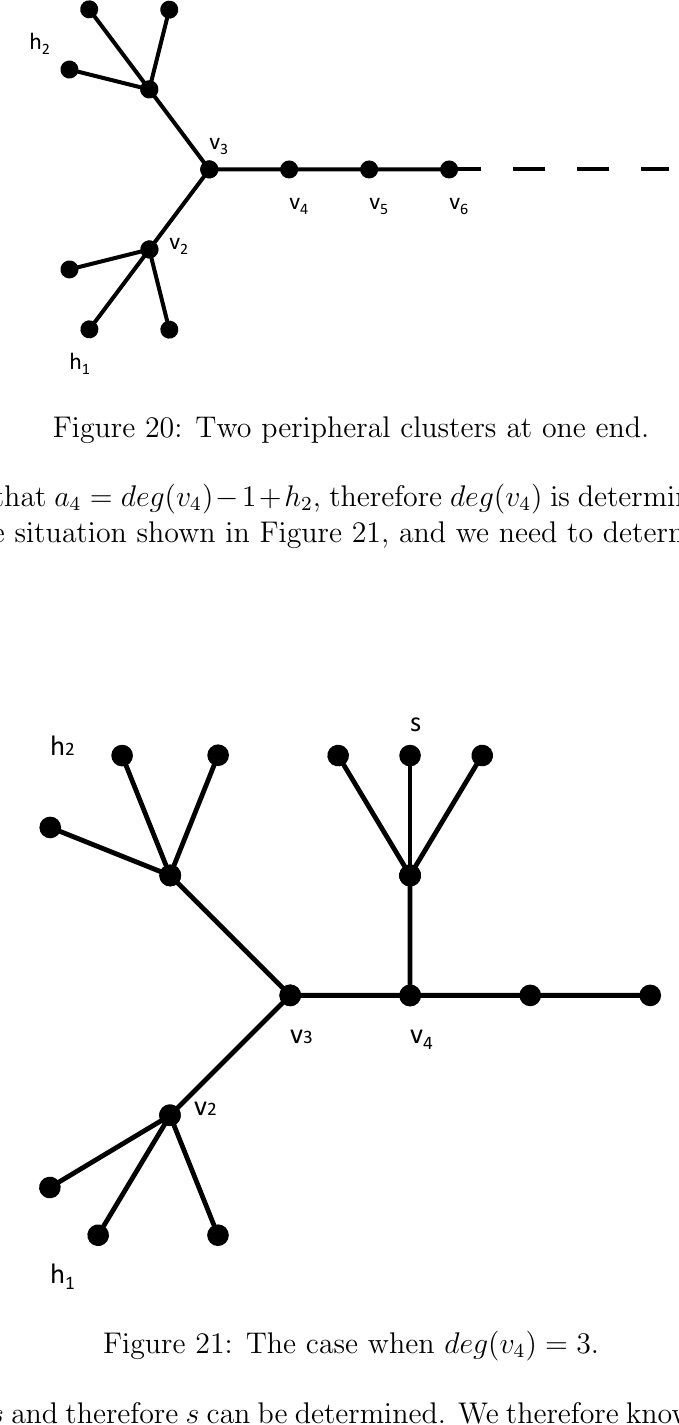
Figure 21: The case when 𝑑𝑒𝑔 ( 𝑣